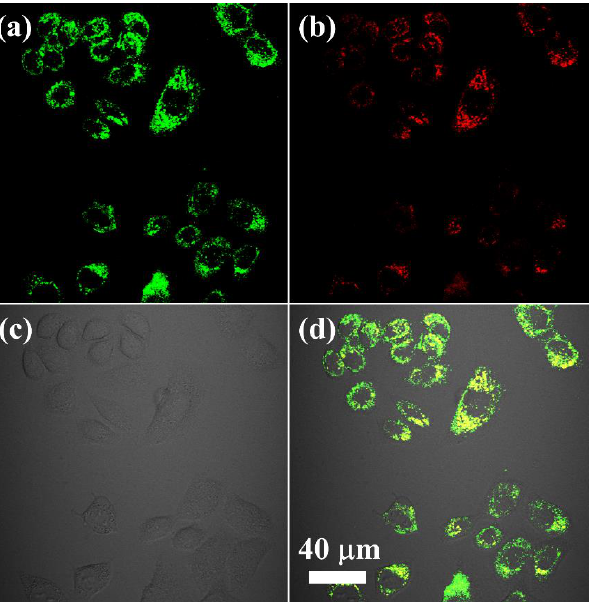
Figure 4. UCL images of living Hela cells after incubation with NaYF 4 :Yb,Er,Ce@SiO 2 -OAlg for three hours. The luminescent images were obtained at a green UCL channel at 500 – 560 nm ( a ) and a red channel at 600 – 700 nm ( b ) by a 980 nm laser. ( c ) The image of the bright field of cells. ( d ) Overlay of green UCL and red UCL images. The scale bar is 40 μm. Unlike fluorescence imaging at the microscopic level of cells, the difficulty of in vivo imaging is the limited penetration depth and spatial resolution of tissues. Here, the R3L3S1N resolution standard card (Figure S5) is used to visually reflect the smallest res- olution distance under different conditions (Figure S6). The mask is used to form a pattern of nanoparticles on the surface; then, the 2 mm pork tissue was added on the top. It was determined by the fluorescence signal changes corresponding to each pixel on the line by drawing a vertical line at the three-line pair. Referring to the Rayleigh criterion, if the line width calculated by data is larger than the actual line width, the minimum distance is determined to be indistinguishable. Compared with the resolution measurement method of the V-shaped capillary tube reported previously [30], this method presents the